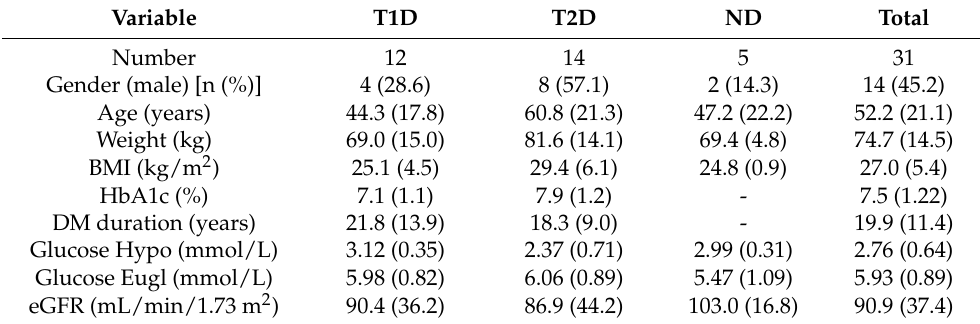
Table 1. Demographic, clinical, and laboratory characteristics of participants (mean ±